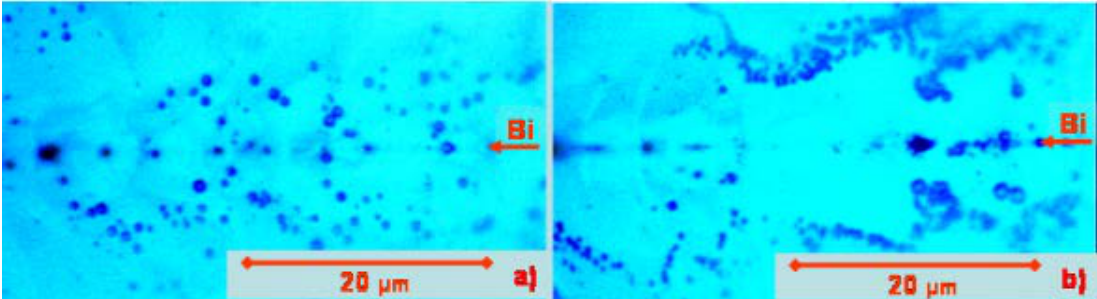
Figure 13. Example of the distribution of the bundles of dislocations along the bicrystalline boundary (36.8°) in SrTiO 3 show a “dramaturgy of the imperfection on the microscale” of the real boundary ( a ). Photography of etch pits (after short etching in HF) was taken using maximal magnification ( b ) with Nikon Optiphot metallurgical microscope with ND 32 filter.